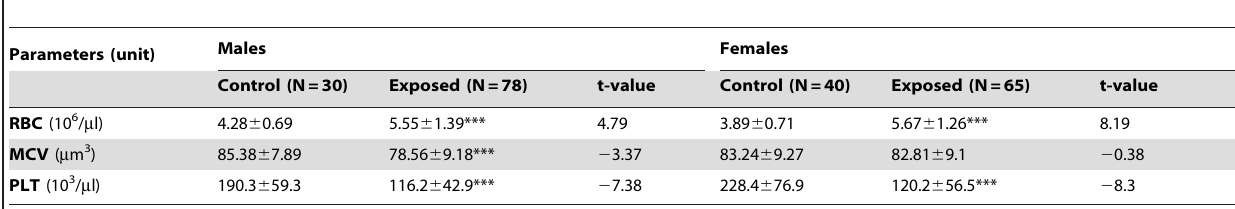
Table 4. Hematological alterations among exposed male and female subjects compared with the controls.